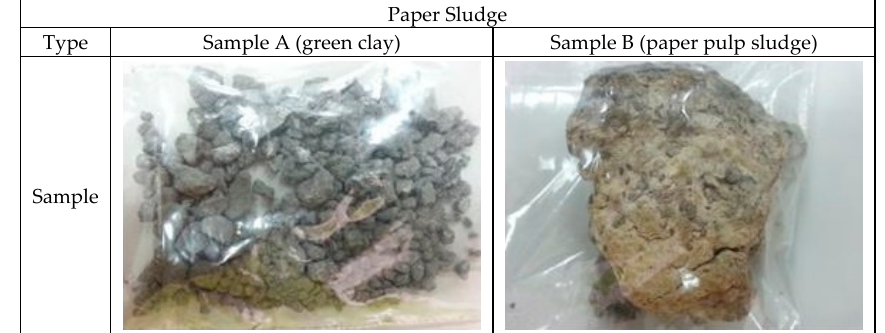
Figure 1. Paper sludge samples.